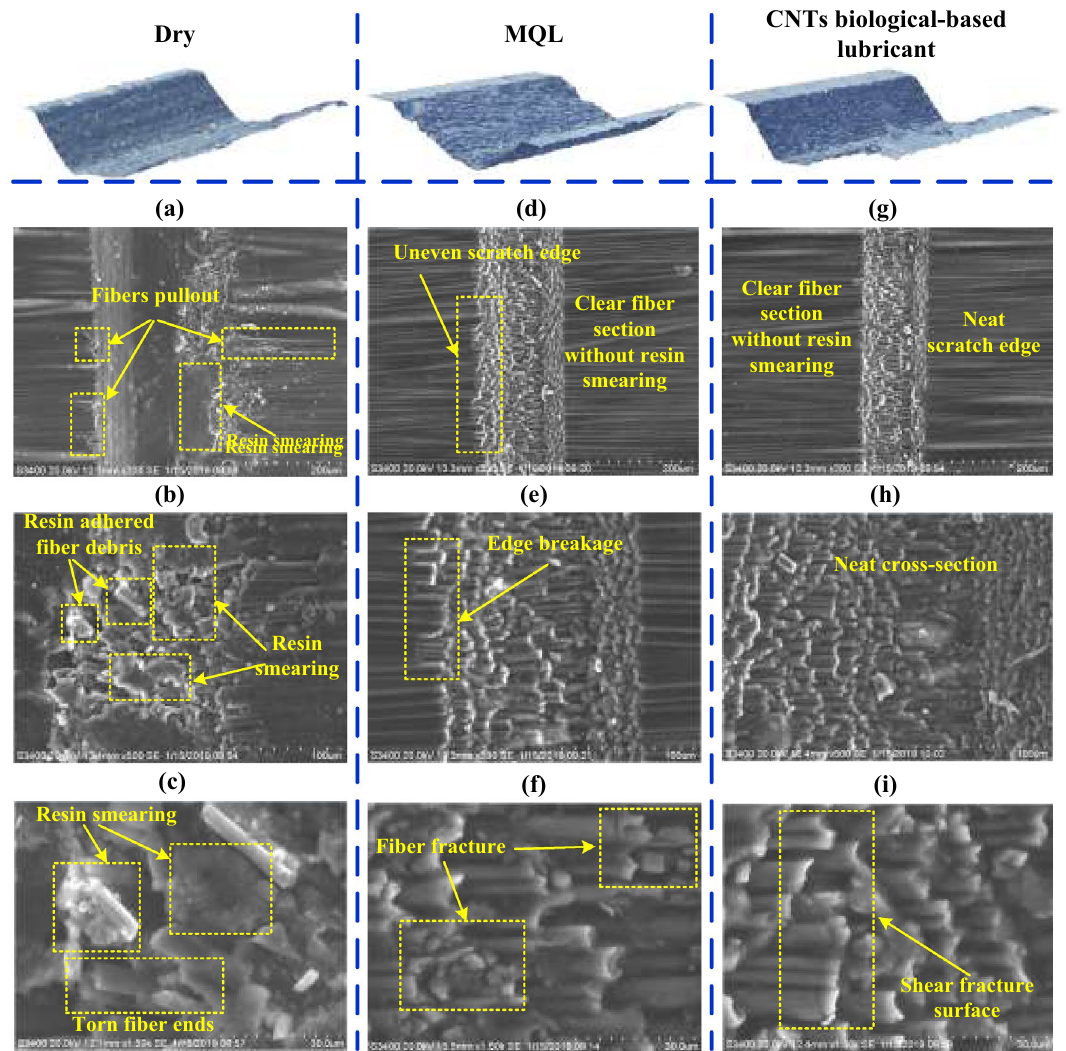
Figure 5. Micromorphology comparison of grinding groove under different lubrication conditions. Figures were created using the Microsoft Visio sofware (version